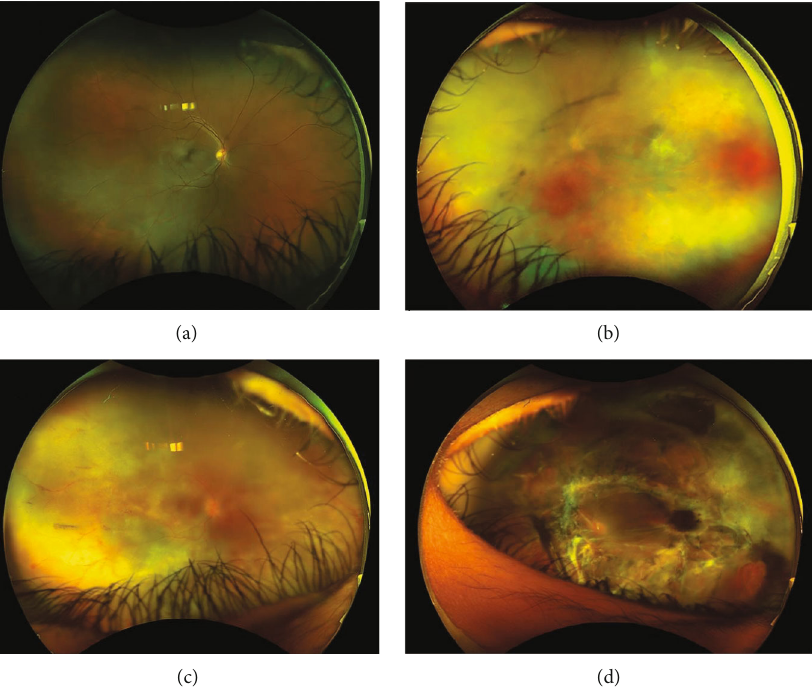
Figure 1: Ultra-wide fi eld fundus photographs of the right (a, c) and left (b, d) eyes. Forty-three months prior to presentation, though the right eye remained uninvolved (a), the left eye developed extensive necrotizing retinitis involving over 80% of the retina. At presentation, the right eye (c) shows vitreous opacities, blurring of the disk margins, and retinal necrosis extending from 1 to 11 o ’ clock in zones 2 and 3 and di ff usely in zone 1, sparing a small patch of the retina temporal to the optic disk. The left eye (d) has persistent retinal traction with fi brous